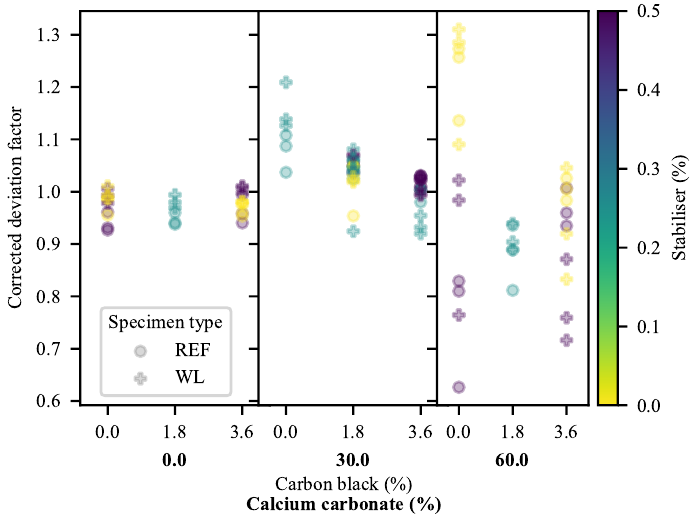
Figure 13. Corrected deviation factor as a function of the loadings of calcium carbonate, carbon black and the stabiliser package. Note the near-independence of the results on additive